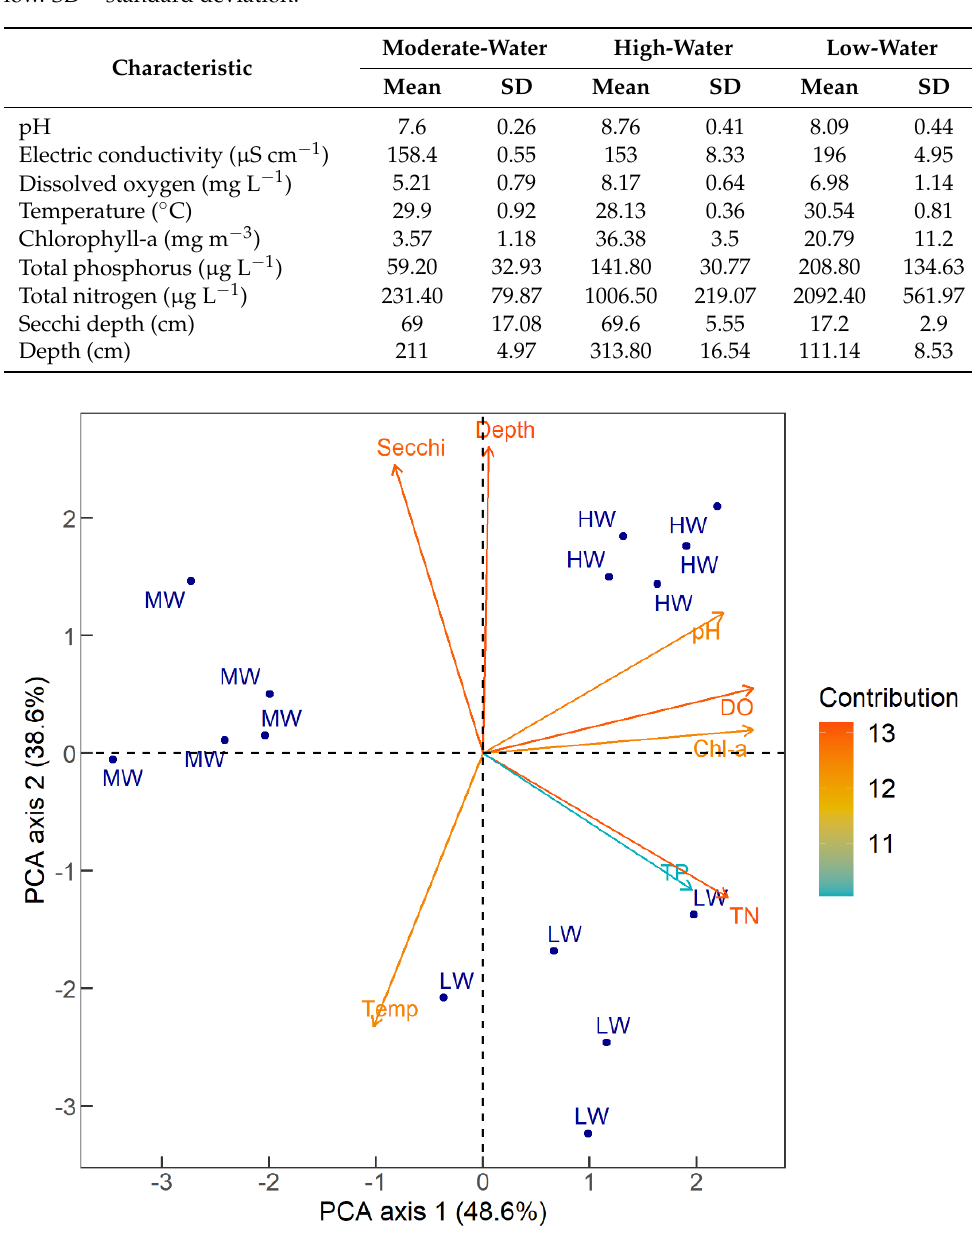
Figure 3. Principal component analysis (PCA) biplot of the biotic and abiotic characteristics of Lake Tempe in different hydrological periods: during the initial flooding period, when the water level was considered moderate (MW); during the post-flooding period, when the water level was maximum (HW); and during the dry period, when the water level was low (LW).